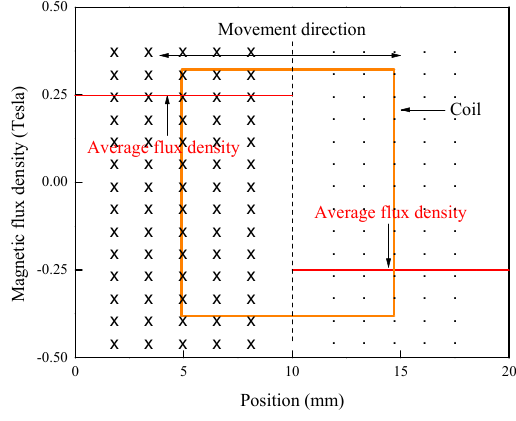
Figure 4. The schematic of the coil in the magnetic field.